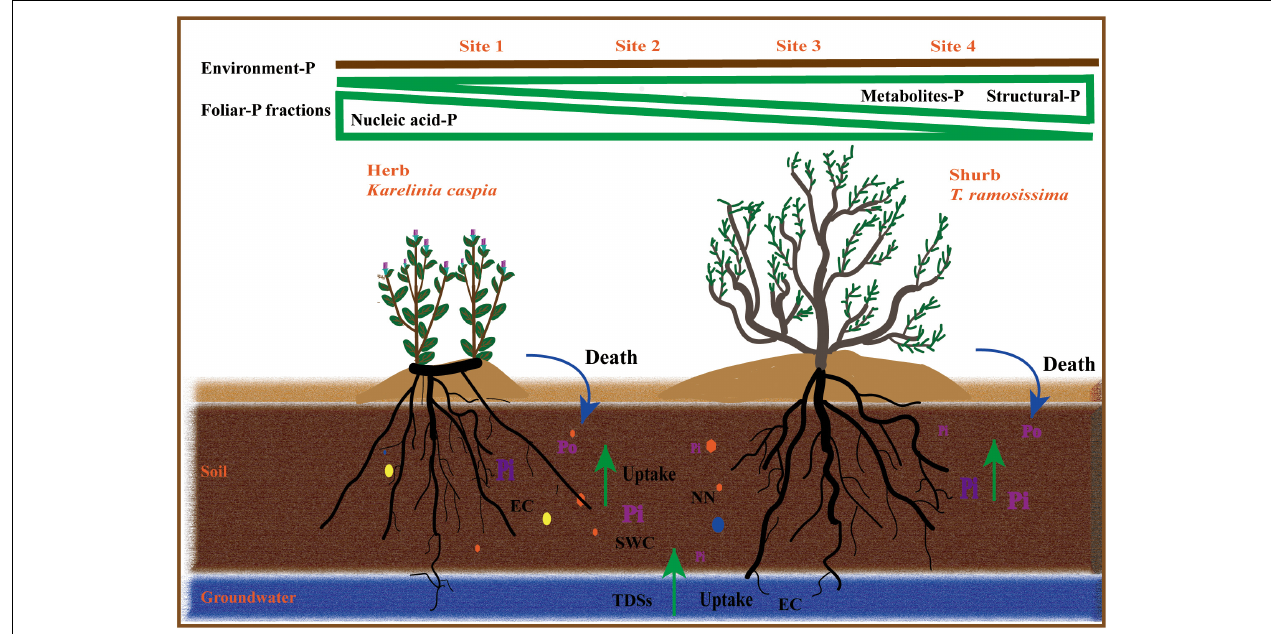
FIGURE 8 | Diagrams summarizing foliar-P fractions allocation of two plant species at different environment-P levels.